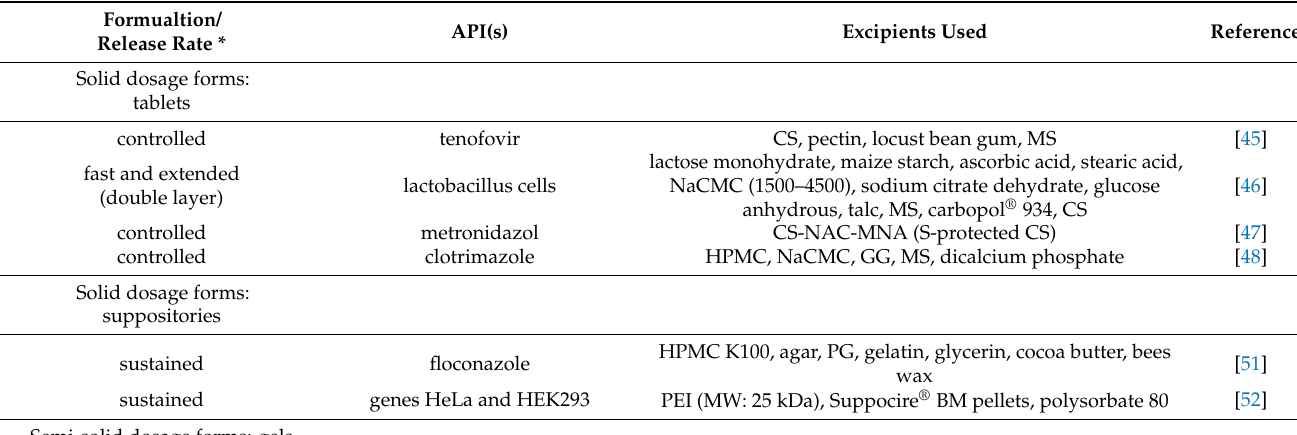
Table 1. An overview of the excipients used in modified release vaginal